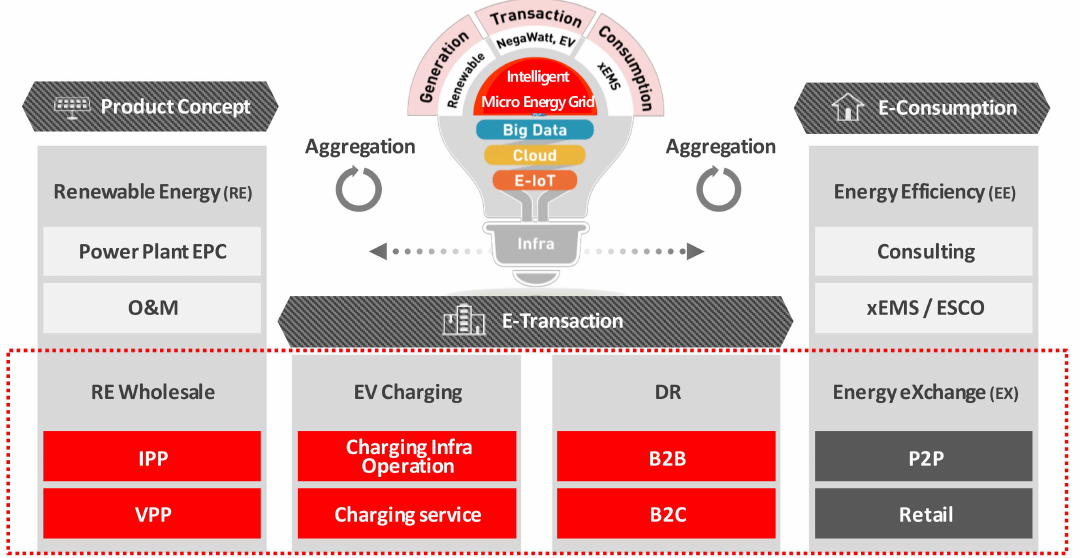
Figure 17. Intelligent micro energy grid operator